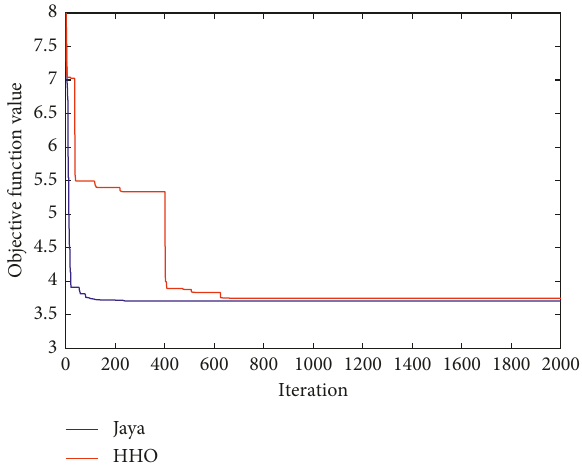
Figure 17: Convergence characteristics for the 4-bus system by NLP formulation.